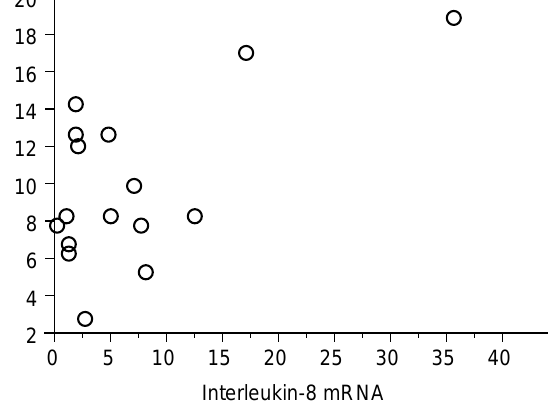
FIG. 4. Correlation between plasma concentration and monocyte mRNA levels from 19 patients with ANCA-asso- ciated vasculitis with different disease activity. Plasma levels were measured (ng/l) using an enzyme-linked immunosor- bent assay. mRNA levels are normalized using b -actin as house keeping gene and the median value of the healthy controls is set to 1.0. The correlation coefficient is 0.374, non- significant.